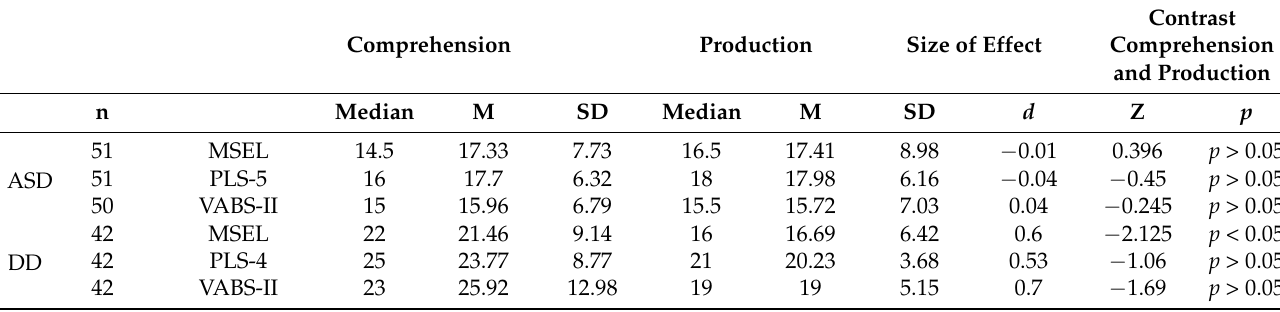
Table 3. Descriptive statistics for equivalent age on language comprehension and production for all measures of language MSEL, VABS-II, and